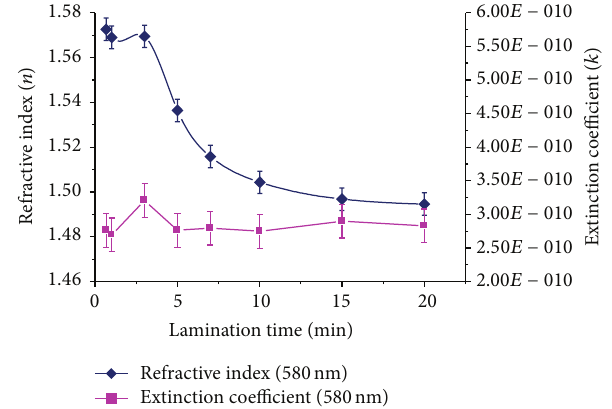
Figure6:TheopticalconstantsofEVAforvariouslaminationtimes, at a lamination temperature of 150 ∘ C, and a wavelength of 580